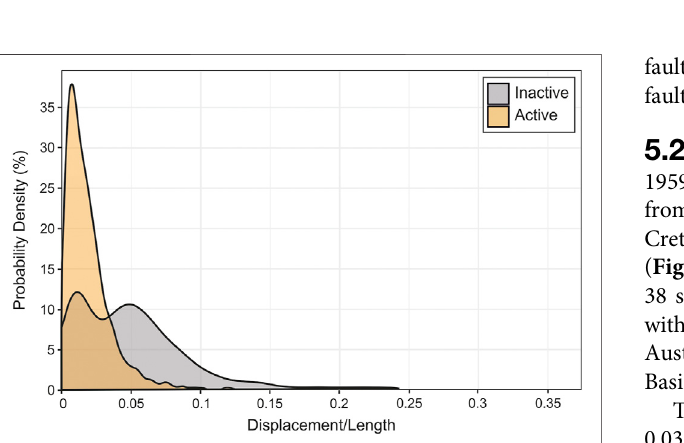
FIGURE 4 | Plots showing fault length vs. displacement for active and inactive normal faults in our database. (A) Data in log-log space. (B) Data in linear space.